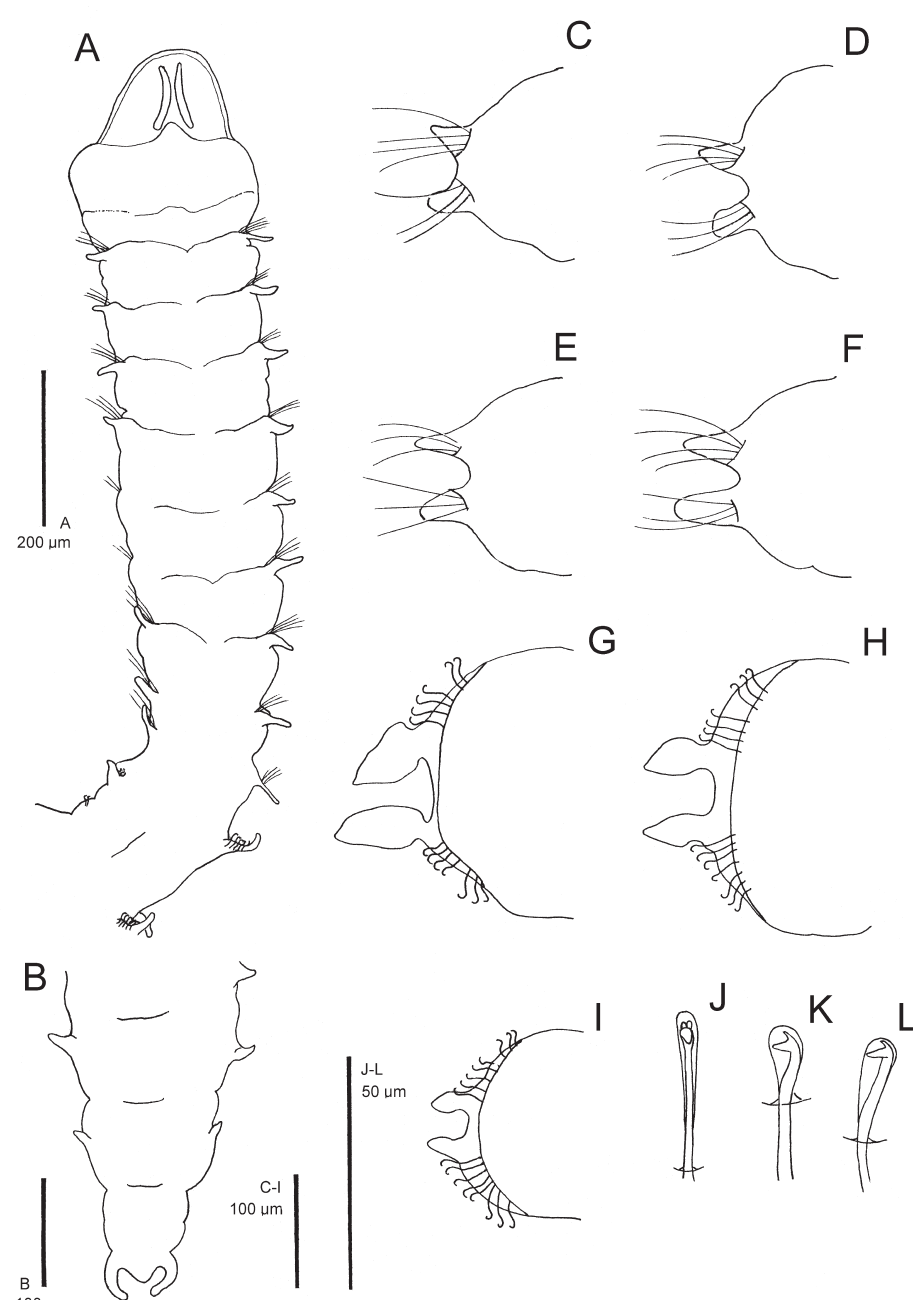
Description . Small, slender species (Fig. 5A); thorax of similar width to abdomen. Largest entire Seychelles specimen ovigerous, with thorax (includ- ing prostomium) 1 mm long, 0.2 mm maximum width, total length 8.0 mm for 43 chaetigers. Other SCI. MAR., 70S3, December 2006, 125-137. ISSN: